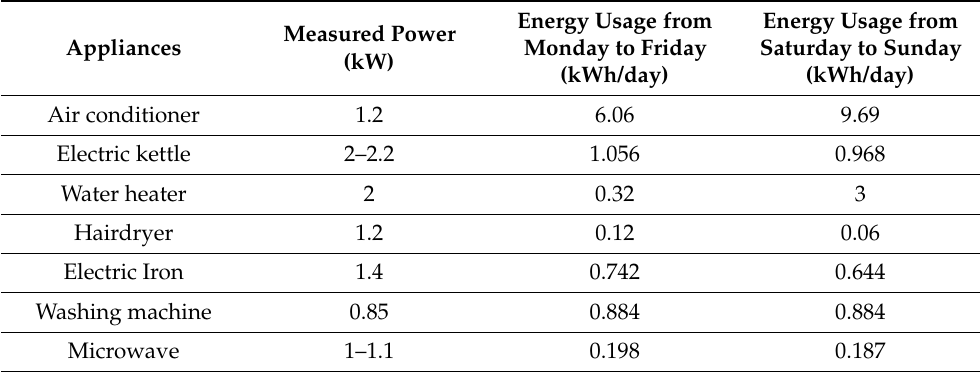
Table 1. Common appliances used in civil building